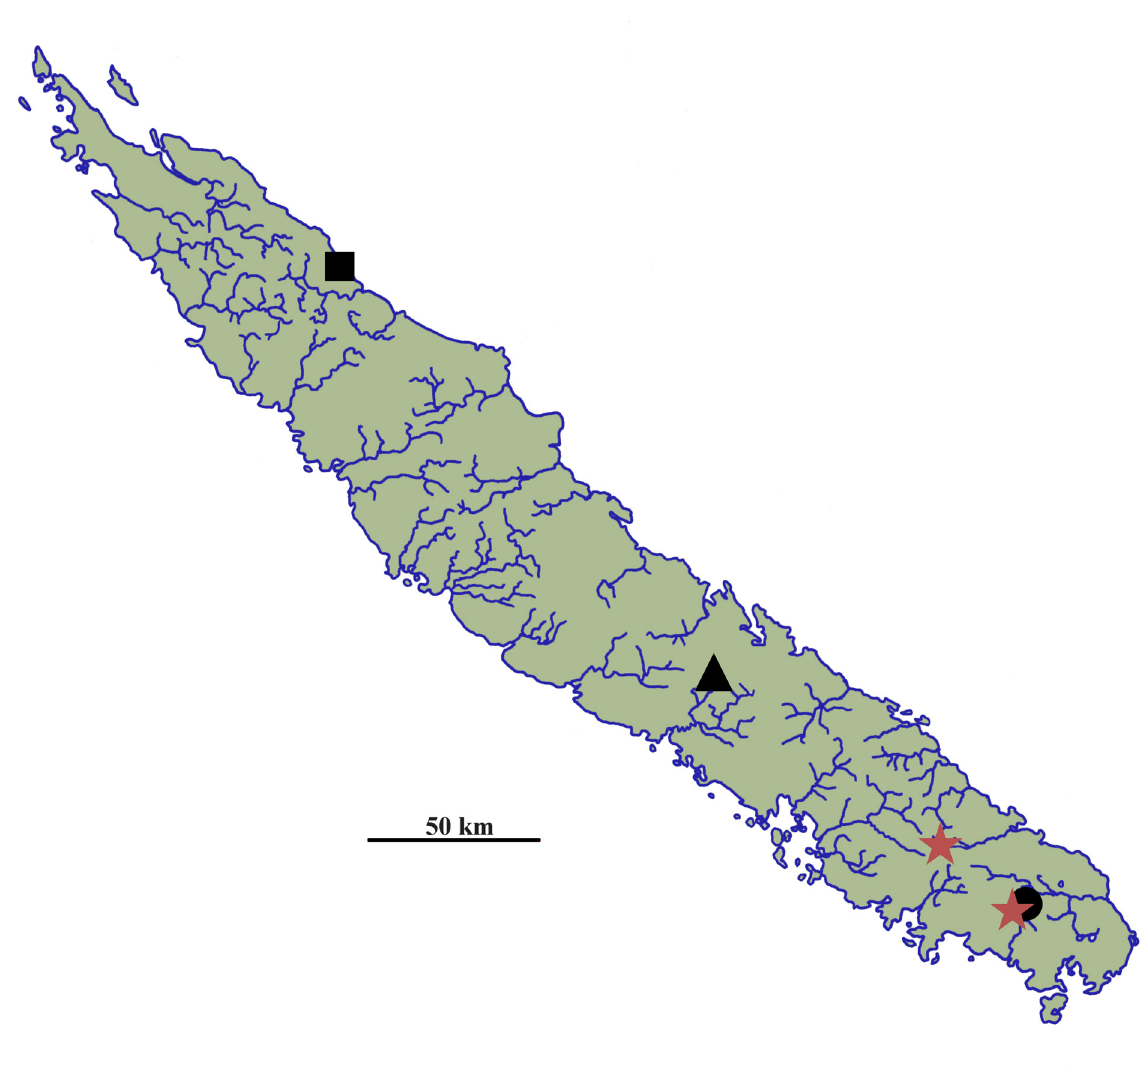
Fig. 16. Map of New Caledonia with collecting sites of Caledomina indicated. Caledomina paniensis sp. nov. (black square), C. dorsospina sp. nov. (black triangle), C. kohensis sp. nov. (black filled circle), C. noumea Johanson, 2011 (red